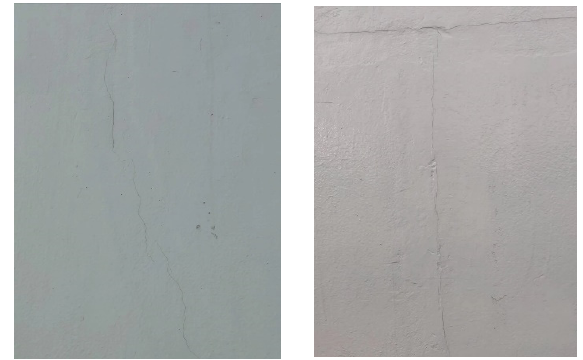
Figure 16. Images of bridge towers.